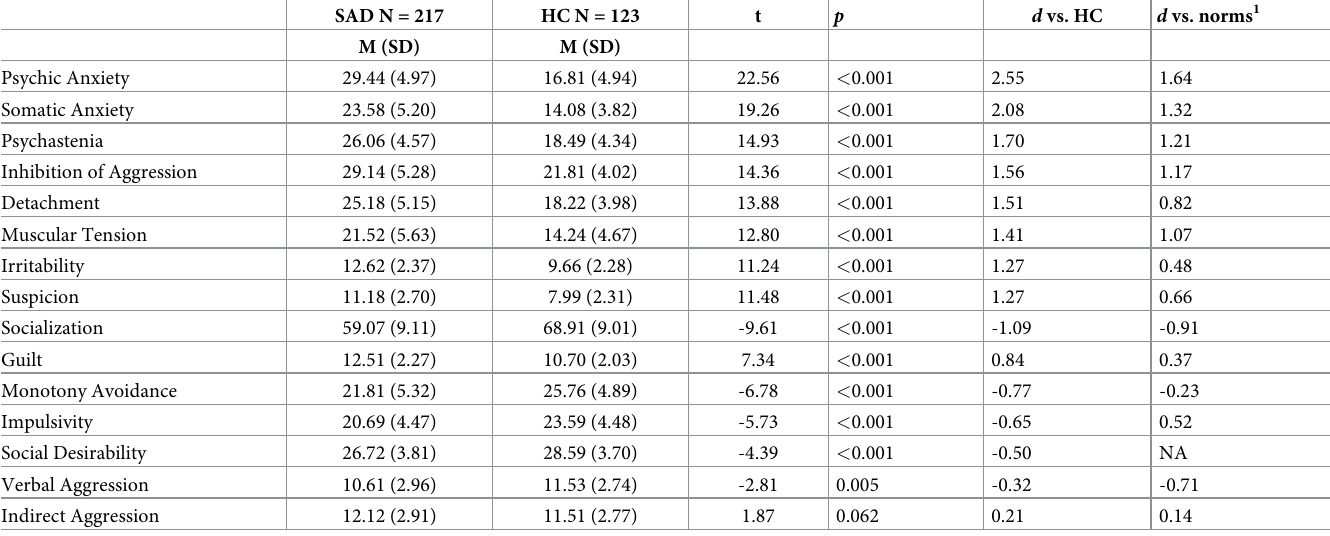
Table 3. Comparison of social anxiety disorder (SAD) patients and Healthy Controls (HC) on the Karolinska Scales of